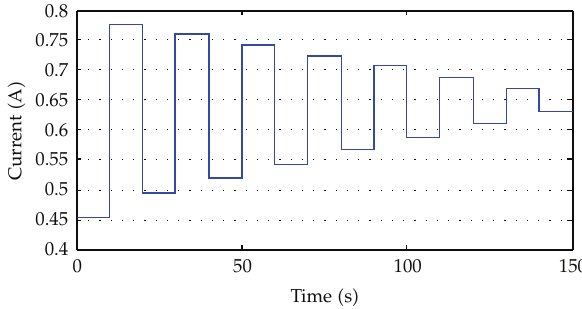
Figure 20: The decaying step current applied in the second validation process.